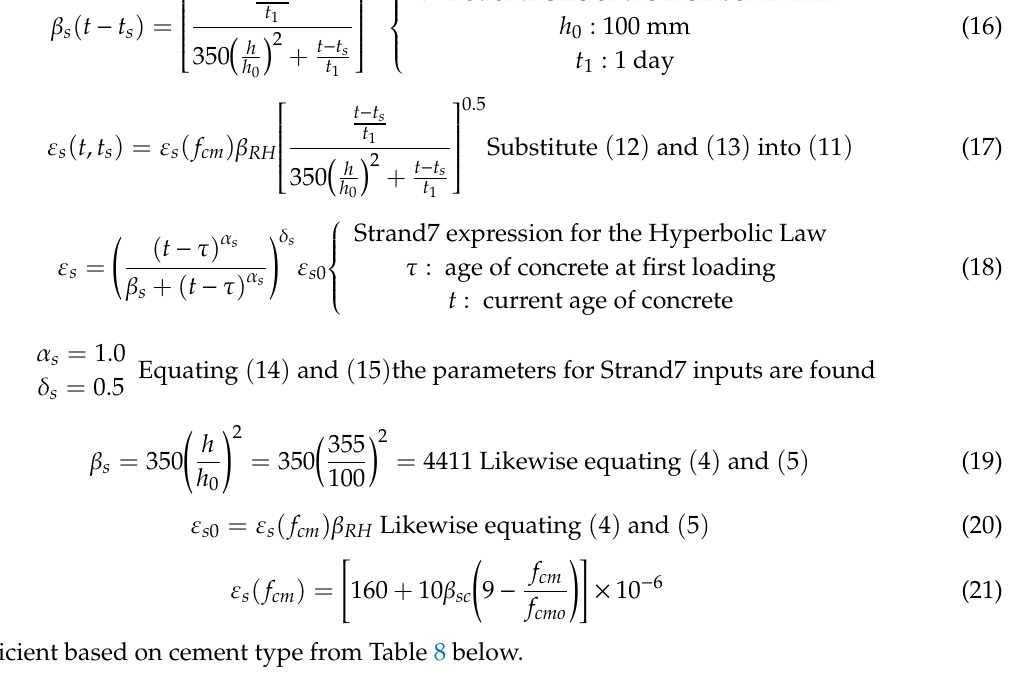
Table 8. Cement type for β sc from Clause 2.1.6.4.4 CEB-FIP Model Code 90 [17].